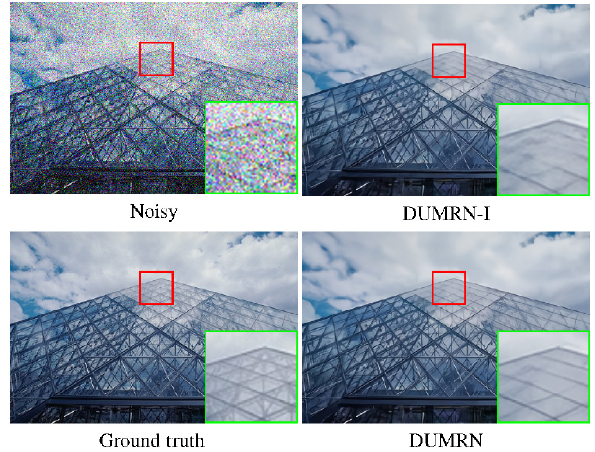
Fig. 8 Effectiveness of the FDM on image denoising. Visual comparison on image 223061 from CBSD68 with noise level σ = 50.